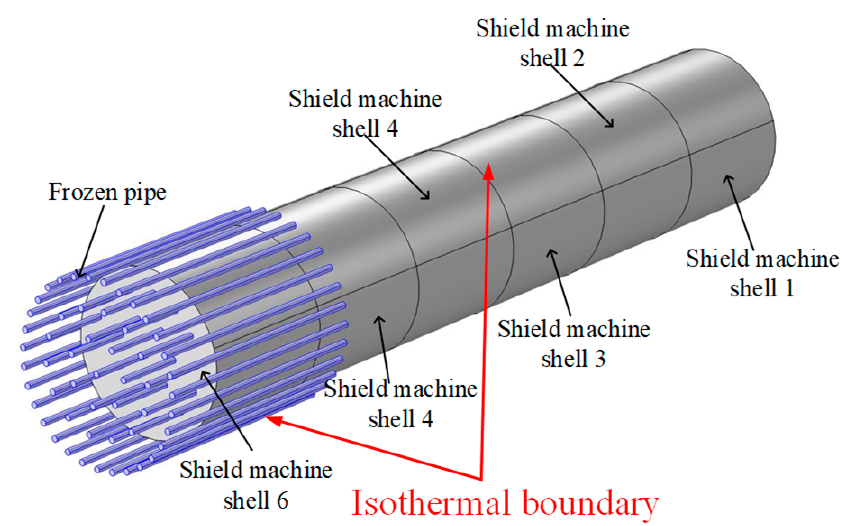
Figure 4. Shield freezing system model.